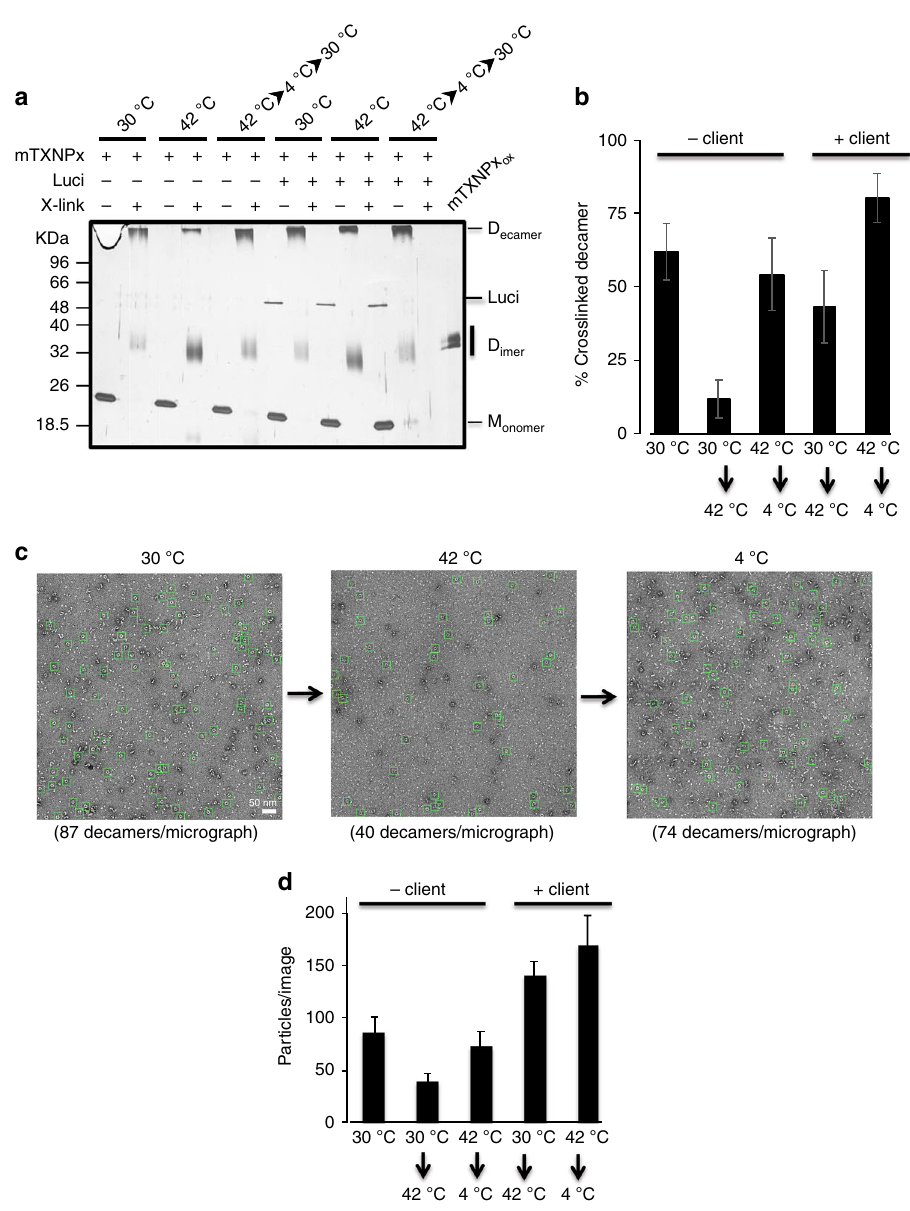
Fig. 6 mTXNPx decamers undergo heat-shock-induced rearrangements. a mTXNPx red (2 µ M) either alone or in complex with luciferase (0.2 µ M) was incubated in the presence ( + ) or absence ( − ) of 40 mM glutaraldehyde at 30 °C or 42 °C for 10 min. The oligomeric status of mTXNPx red was assessed by running the samples on non-reducing SDS-PAGE followed by silver staining. Dimeric mTXNPx ox was used as control. In the absence of cross-linker, mTXNPx red migrates in the monomeric form. b Three independent experiments were quanti fi ed using ImageJ software. Values represent means ± SD. c mTXNPx red (10 µ M) was incubated either alone or in the presence of luciferase (1 µ M) for 10 min at 42 °C. One aliquot was immediately applied onto an EM grid while the other aliquot was cooled down before applying onto the grids. d Quanti fi cation of the number of decamers present in 10 micrographs for each condition + / − std is